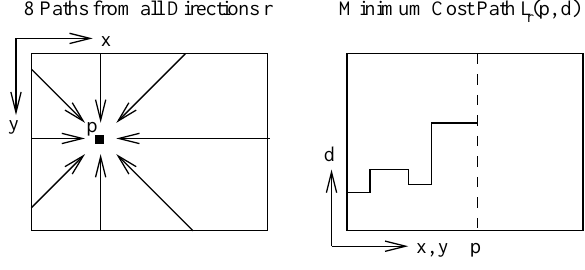
Figure 1: Aggregation of costs in disparity space. Along each path L r , the minimum cost to reach all disparities of a pixel p on the path is computed according to the global cost function (1). The minimum cost along a path is visualized on the right in Figure 1. Mathematically, the cost computation is done